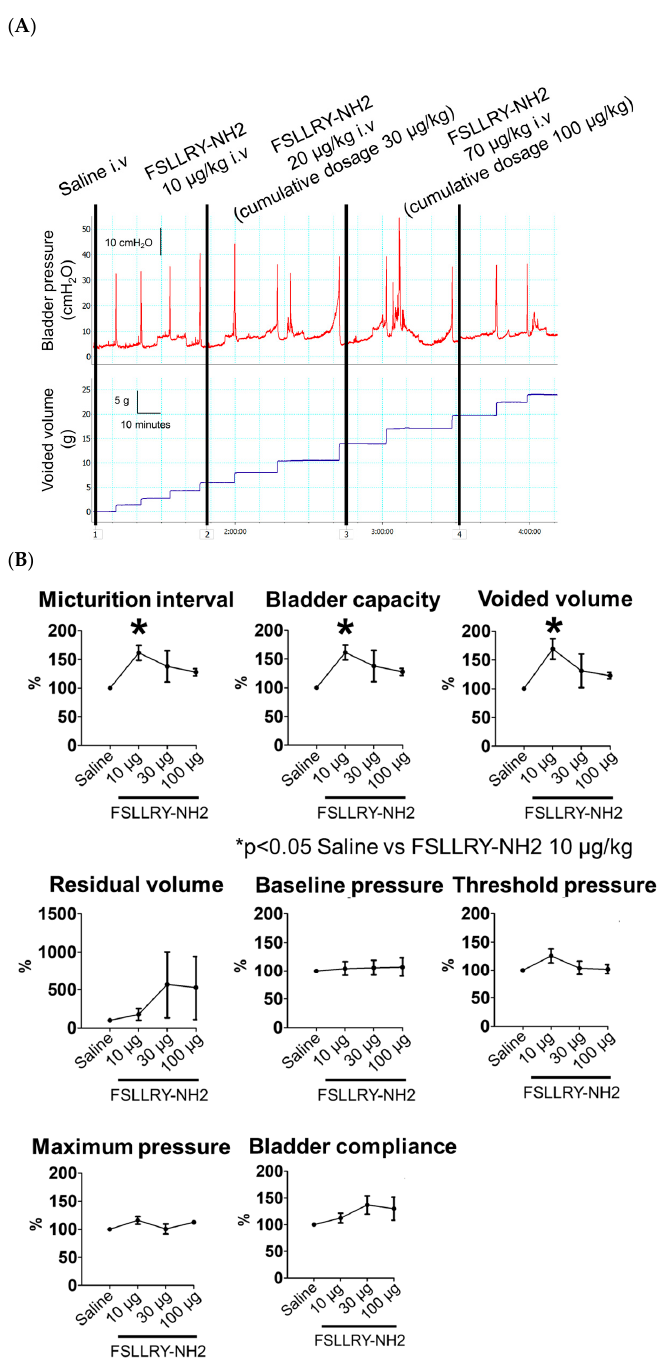
Figure 3. ( A ) Representative cystometrogram recordings with intravenous administrations of FSLLRY-NH2, a PAR2 antagonist, in a rat with chronic bladder ischemia (CBI). The cystometrograms were recorded continuously after intravenous injection of saline, and 10 µ g/kg, 20 µ g/kg (cumulative dosage 30 µ g/kg) and 70 µ g/kg (cumulative dosage 100 µ g/kg) of FSLLRY-NH2 in sequence. Scale bars represent 10 min, 10 cm H 2 O and 5 mL. ( B ) Effects of FSLLRY-NH2, a PAR2 antagonist, on cystometric parameters of the rat model of chronic bladder ischemia (CBI). Values (mean ± SEM) are expressed as the ratio (%) of cystometric parameters with each dose of FSLLRY-NH2 injection relative to the corresponding parameters with saline. * p < 0.05 (Friedman and Bonferroni